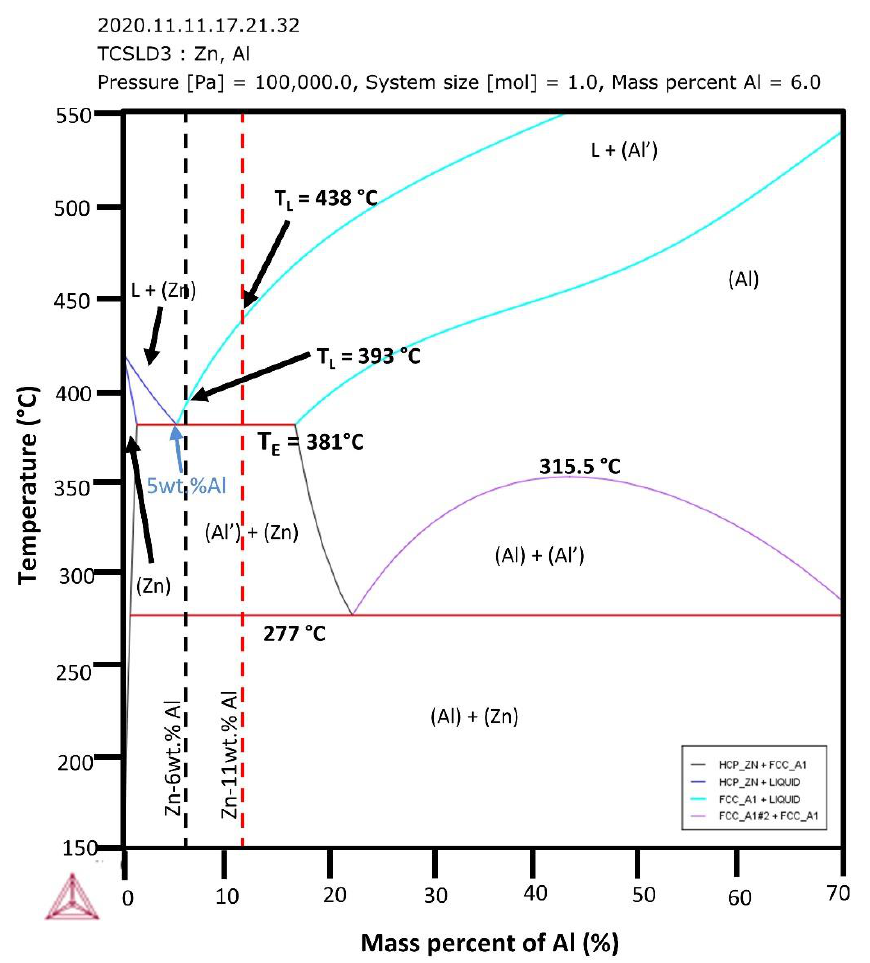
Figure 2. Partial phase diagram of the Zn – Al system calculated by the ThermoCalc software (TCS Solder Alloy Solutions version 3 Database [33]).